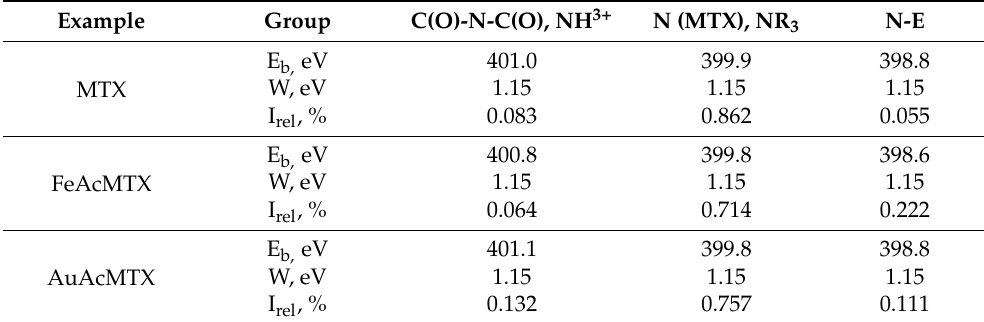
Table 1. Parameters of components in the N 1s photoelectron spectra of the methotrexate and its conjugates with metal nanoparticles: E b —binding energy, W—peak width, and I rel —relative